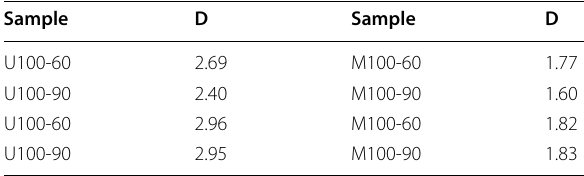
Table 3 Fractal dimensions, D , obtained from SAXS profiles